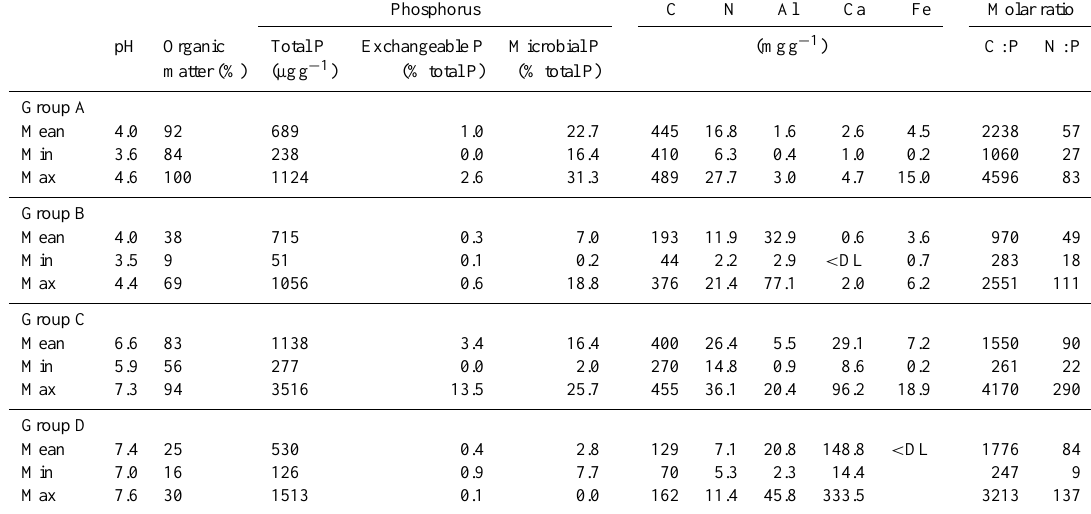
Table 1. Soil biogeochemical characteristics of four wetland groups derived from 28 study sites. Phosphorus C N Al Ca Fe Molar ratio pH Organic Total P Exchangeable P Microbial P (mgg − 1 )